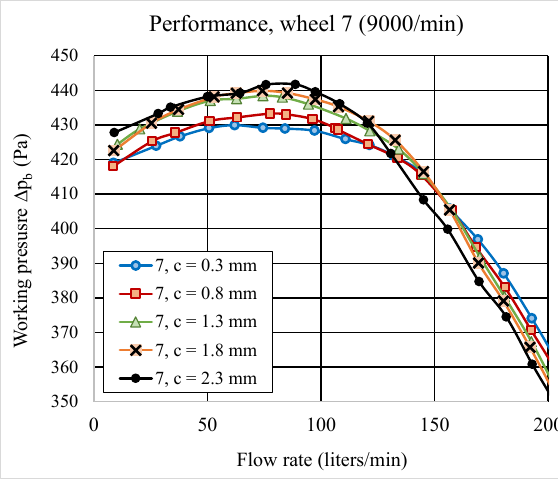
Fig. 10 Fan output for wheel 7 and various mutual position of wheel and the shaft c , maximum working